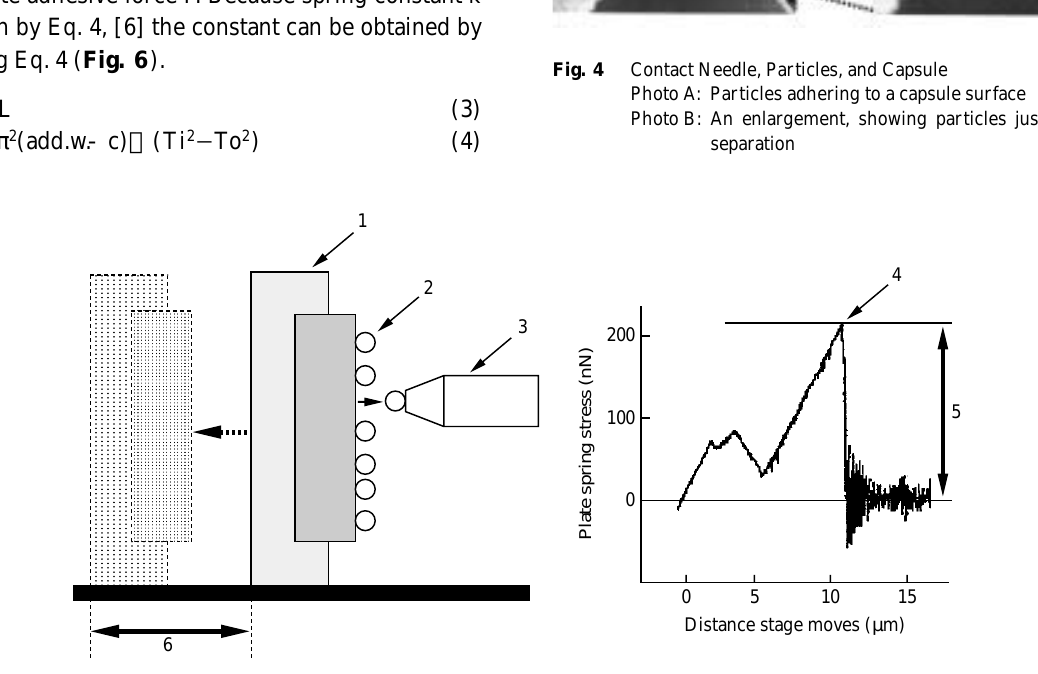
Distance stage moves ( µ m)